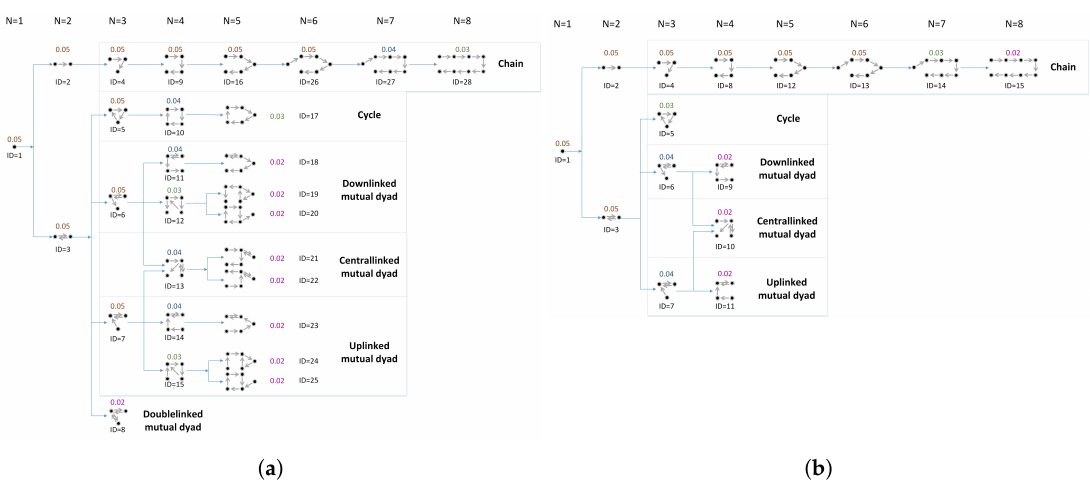
Figure 3. Dendrogram of topological travel motifs based on ( a ) discrete sequence and ( b ) consecutive sequence. Note that N denotes the number of attractions within the identified motif; the value above each motif indicates the threshold (cid:101) m % for detecting it as a significant motif; and the “double-linked mutual dyad” motif is excluded for analysis in that its corresponding threshold is lower than